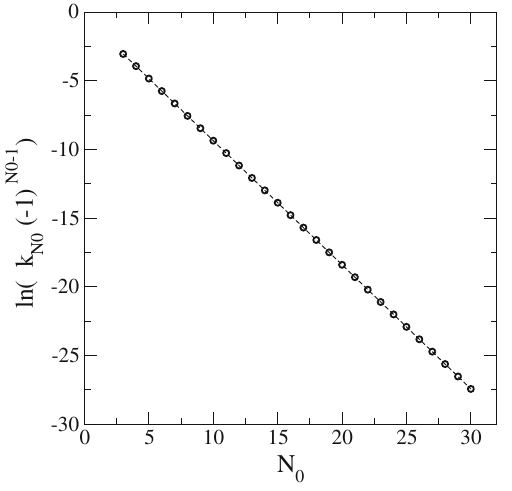
= k N 0 of the expansion N 0 0